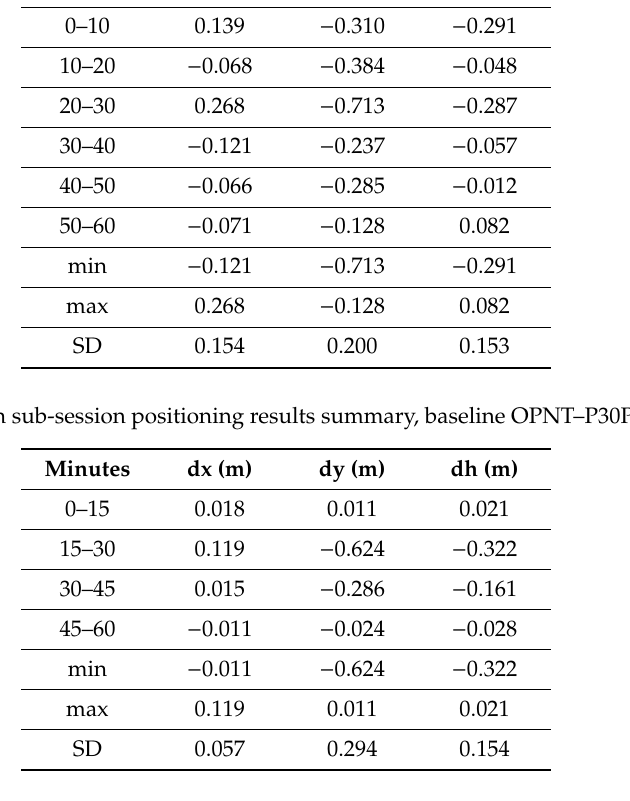
Table 13. 20 min sub-session positioning results summary, baseline OPNT–P30Pro (4